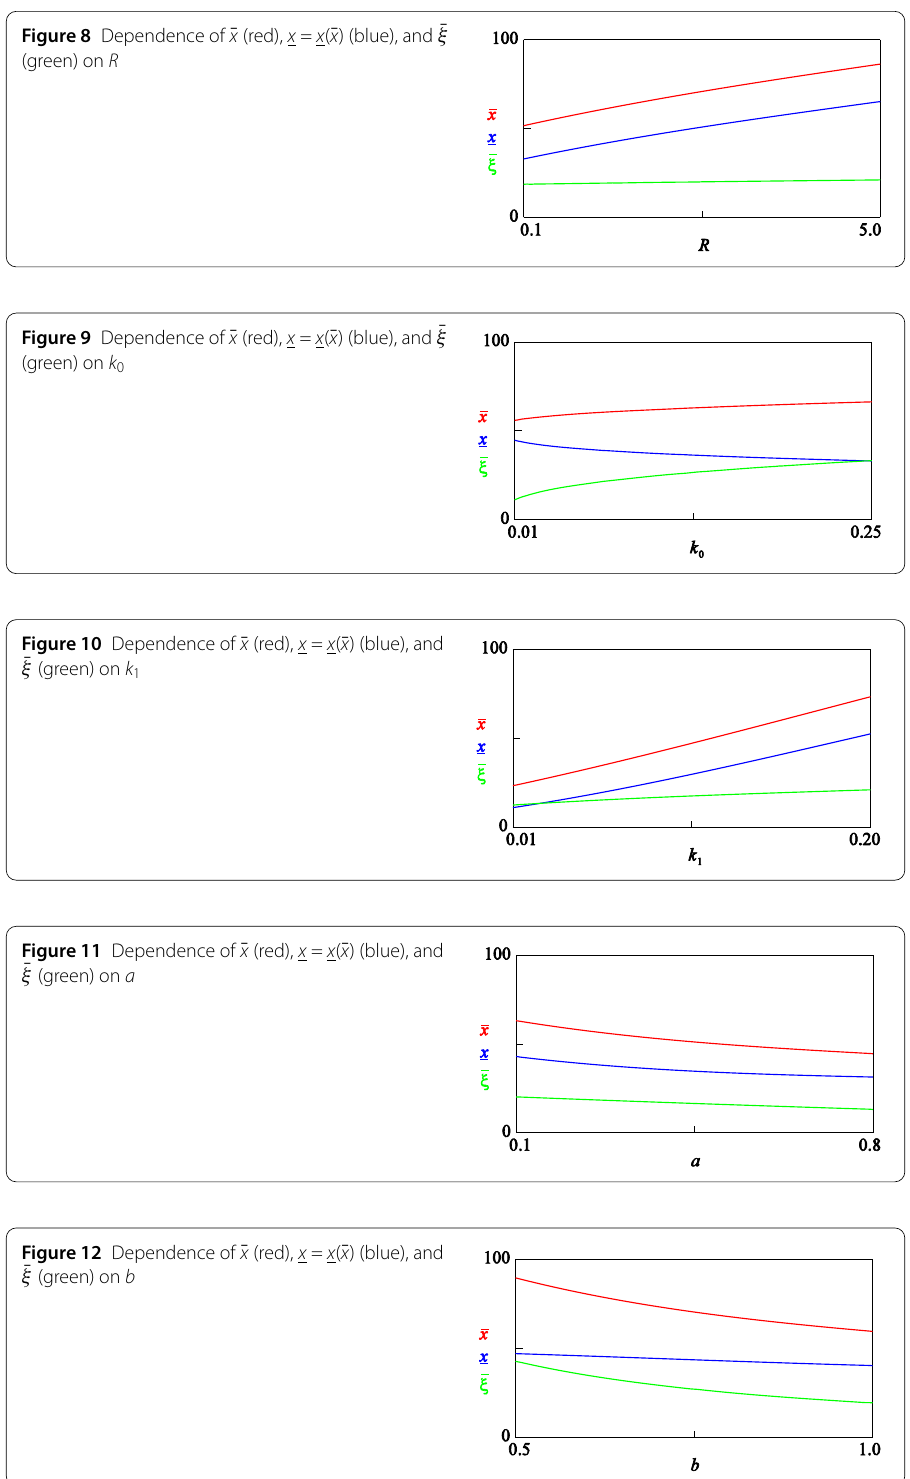
Figure 8 Dependence of ¯ x (red), x = x ( ¯ x ) (blue), and ¯ ξ (green) on R